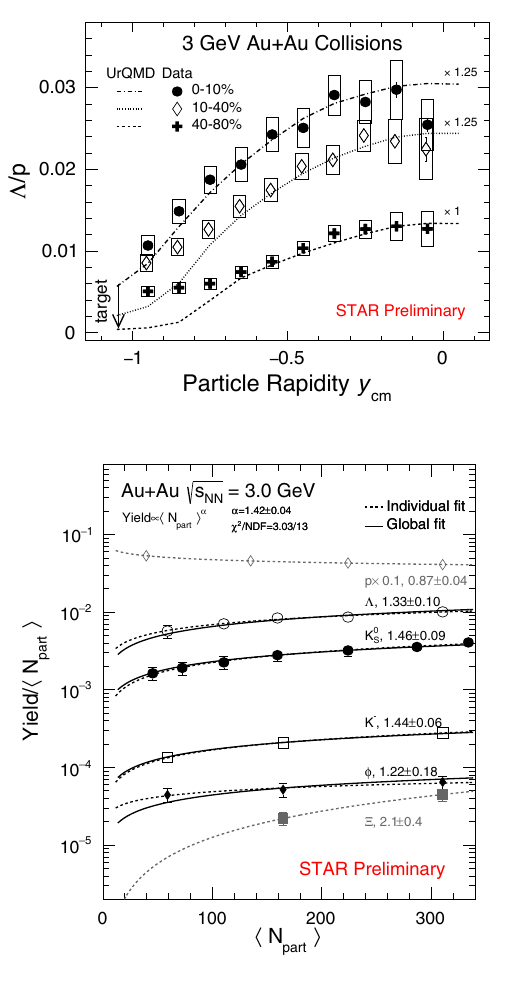
Figure 2. Rapidity dependence of Λ / p for di ff erent centrality bins in Au + Au collisions at √ s NN = 3 GeV. Vertical lines represent statistical uncertainties, while boxes represent systematic uncertainties. 10-40% centrality is shifted left for better visibility. The curves represent the calculations from UrQMD and are scaled up to compare with data.